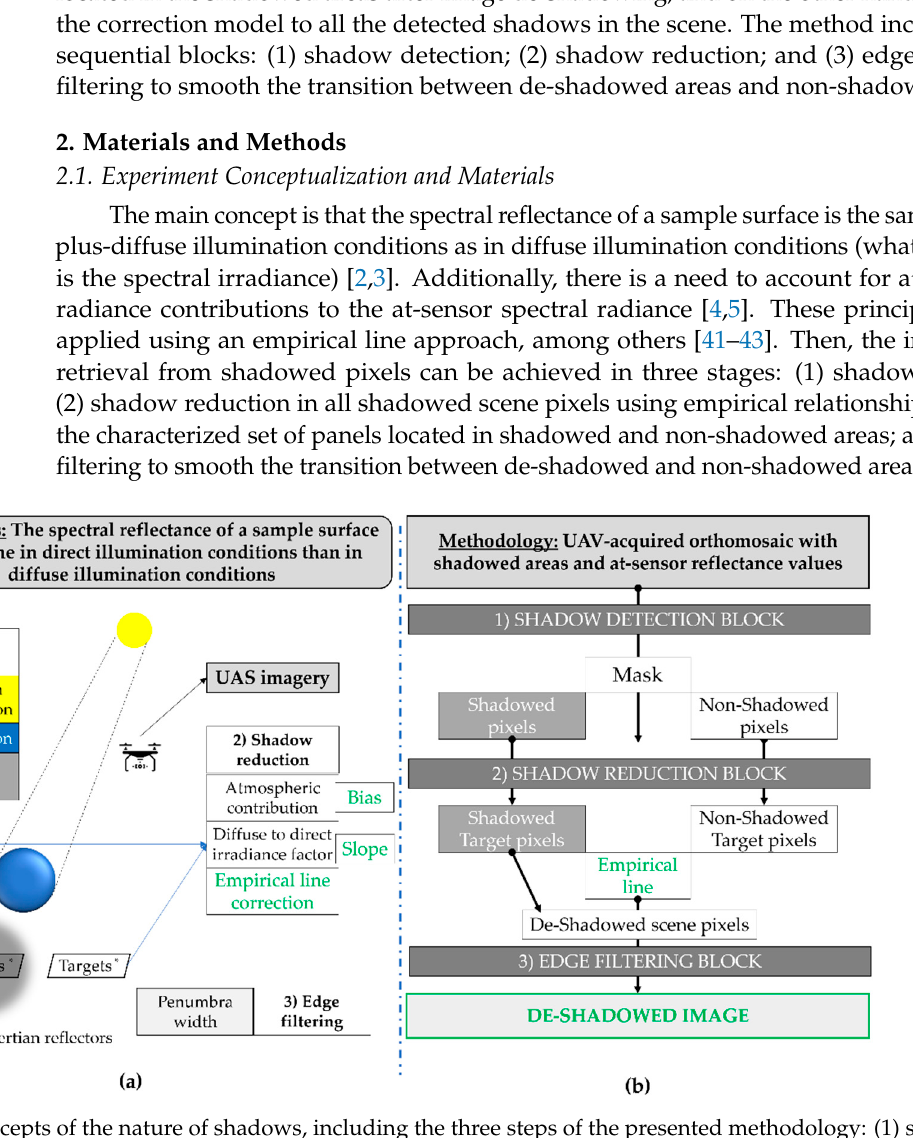
Figure 1. ( a ) Basic concepts of the nature of shadows, including the three steps of the presented methodology: (1) shadow detection; (2) shadow correction; (3) edge filtering. ( b ) General workflow for obtaining de-shadowed images from UAV orthomosaics with shadowed areas.